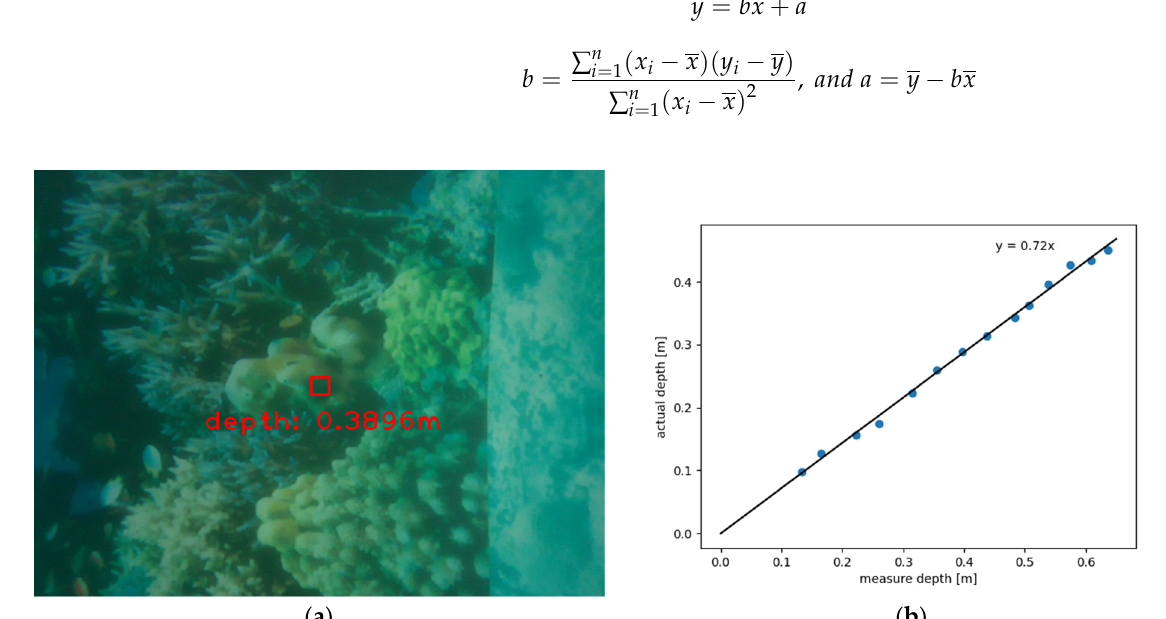
Figure 6. ( a ) Underwater depth test; ( b ) The mathematical relationship of camera underwater rang- ing.